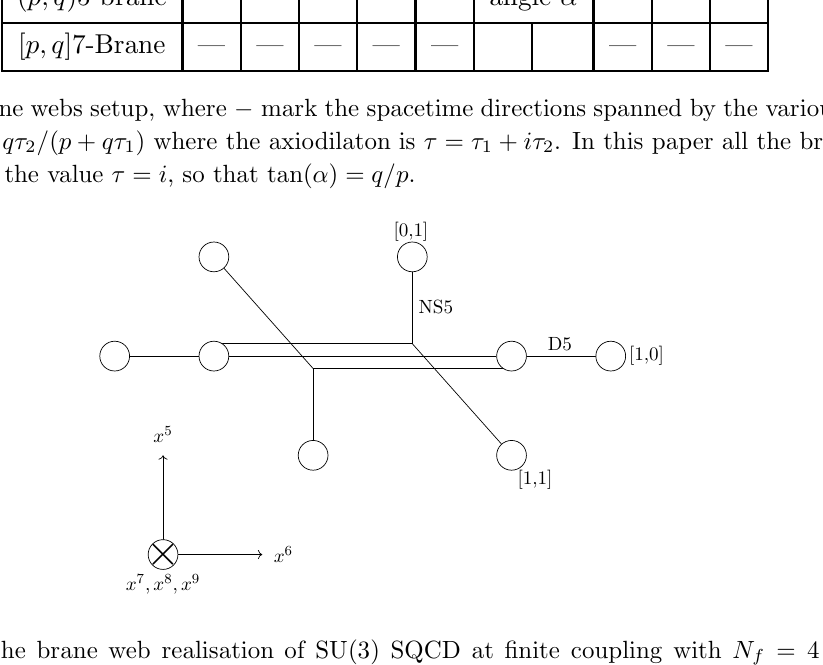
Figure 3 . The brane web realisation of SU(3) SQCD at finite coupling with N f = 4 massless flavours at the origin of its moduli space. Horizontal lines correspond to D5 branes, vertical lines from the x 5 axis correspond to ( p, q )5-branes correspond to NS5 branes, lines at an angle tan( α ) = p q and circles correspond to [ p, q ]7-branes. Note that ( p, q )5-branes end on [ p, q ]7-branes. The parallel D5 branes are supposed to coincide in space and are drawn slightly appart for